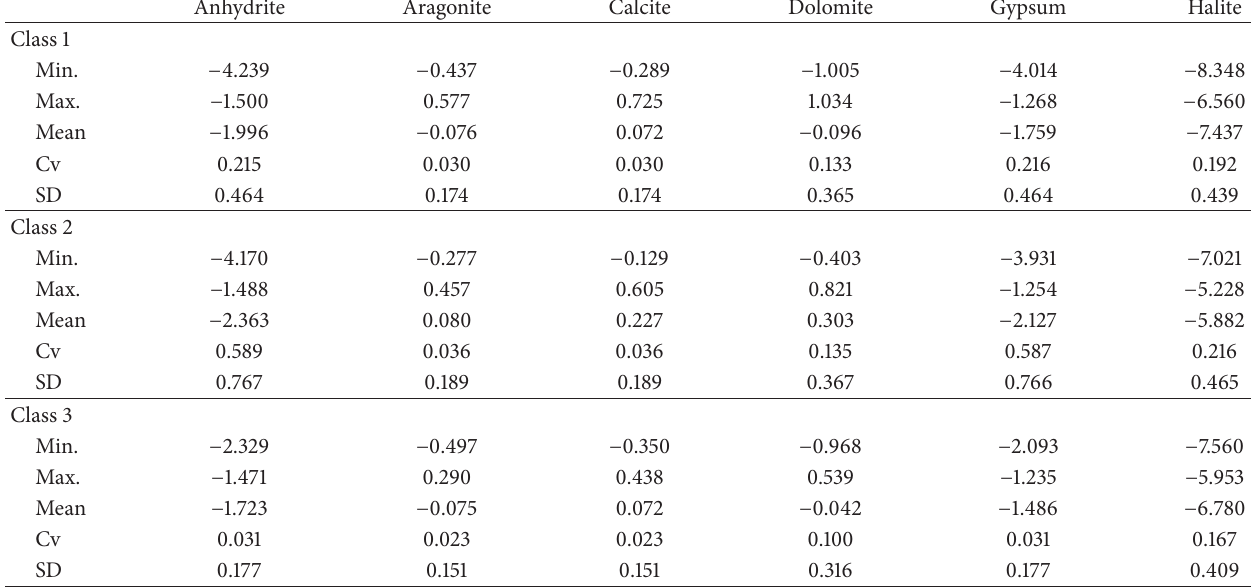
Table 4: Statistical summary of saturation indexes of minerals in groundwater using